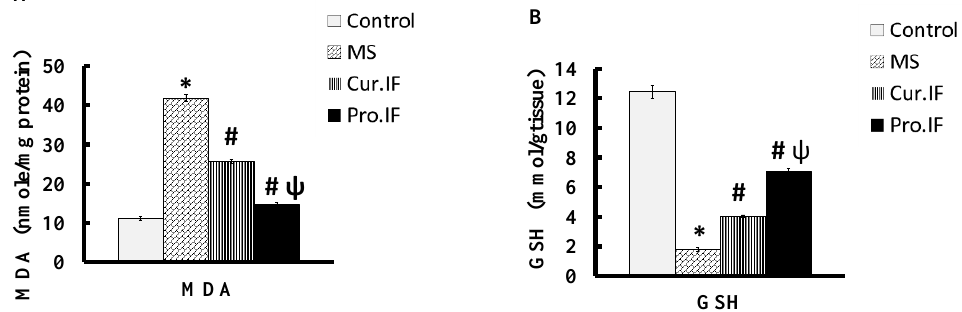
Figure 5. Effect of HFD and/or pro. and cur. IF on the brain tissue contents of MDA ( A ) and GSH ( B ) in all studied groups * HFD significant vis. control group, # pro. and cur. IF significant vis. HFD group, ψ pro. IF significant vise cur. IF.